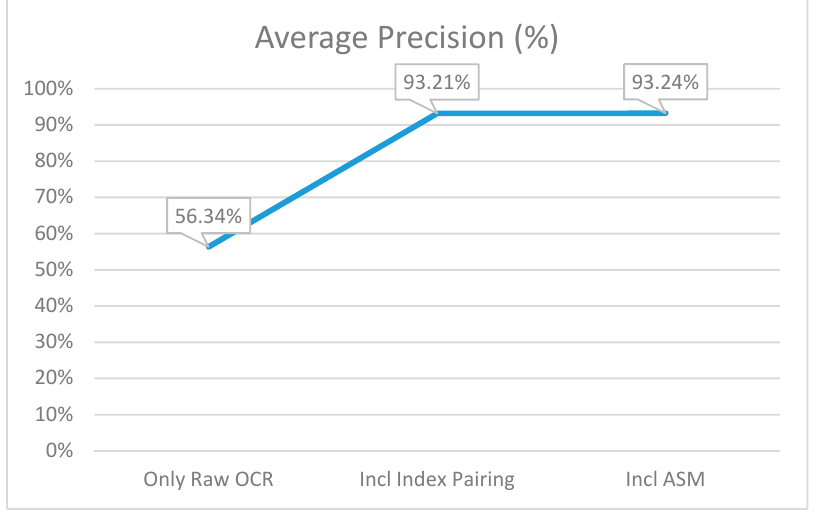
Figure 6. Accuracy measurement points in workflow to show improvements as new functionality is introduced.